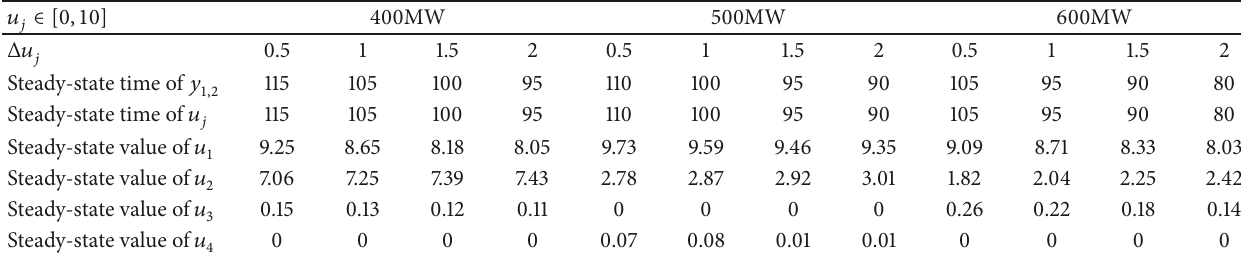
Table 6: Steady-state values of 𝑢 𝑗 when 𝑢 𝑗 ∈ [0,10] .